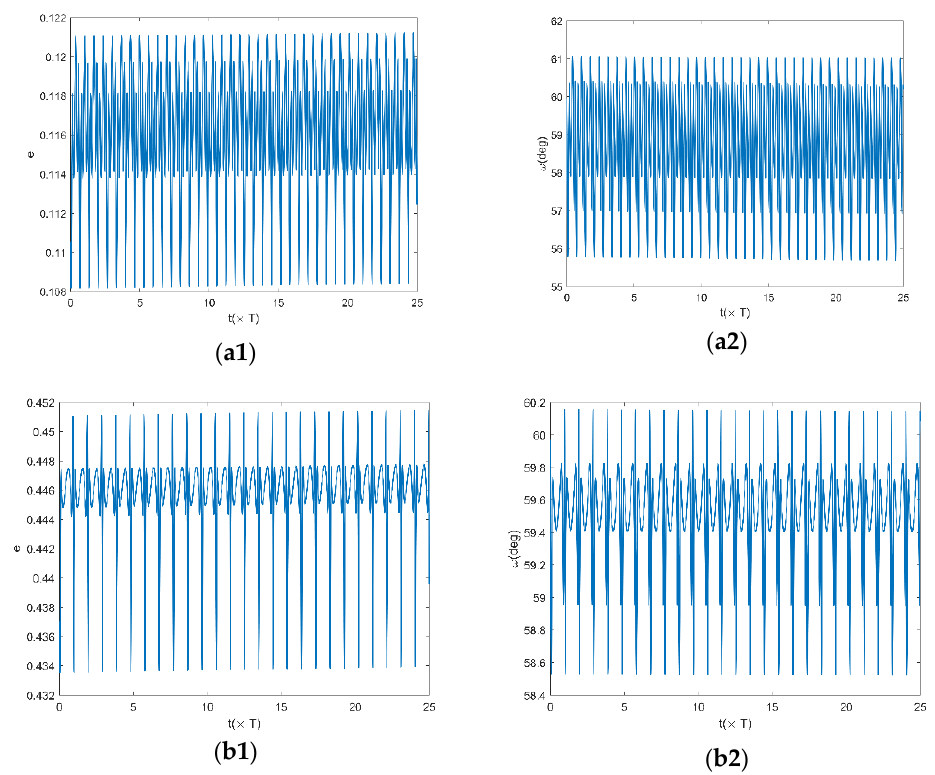
Figure 7. Evolution of ω and e over 25 T , ( a1 , a2 ) a = 1.6832 R = 120,335.334 km, i = 63.497 deg; ( b1 , b2 ) a = 2.1488 R = 153,622.009 km, i = 63.431 deg, where T is a Jovian day.